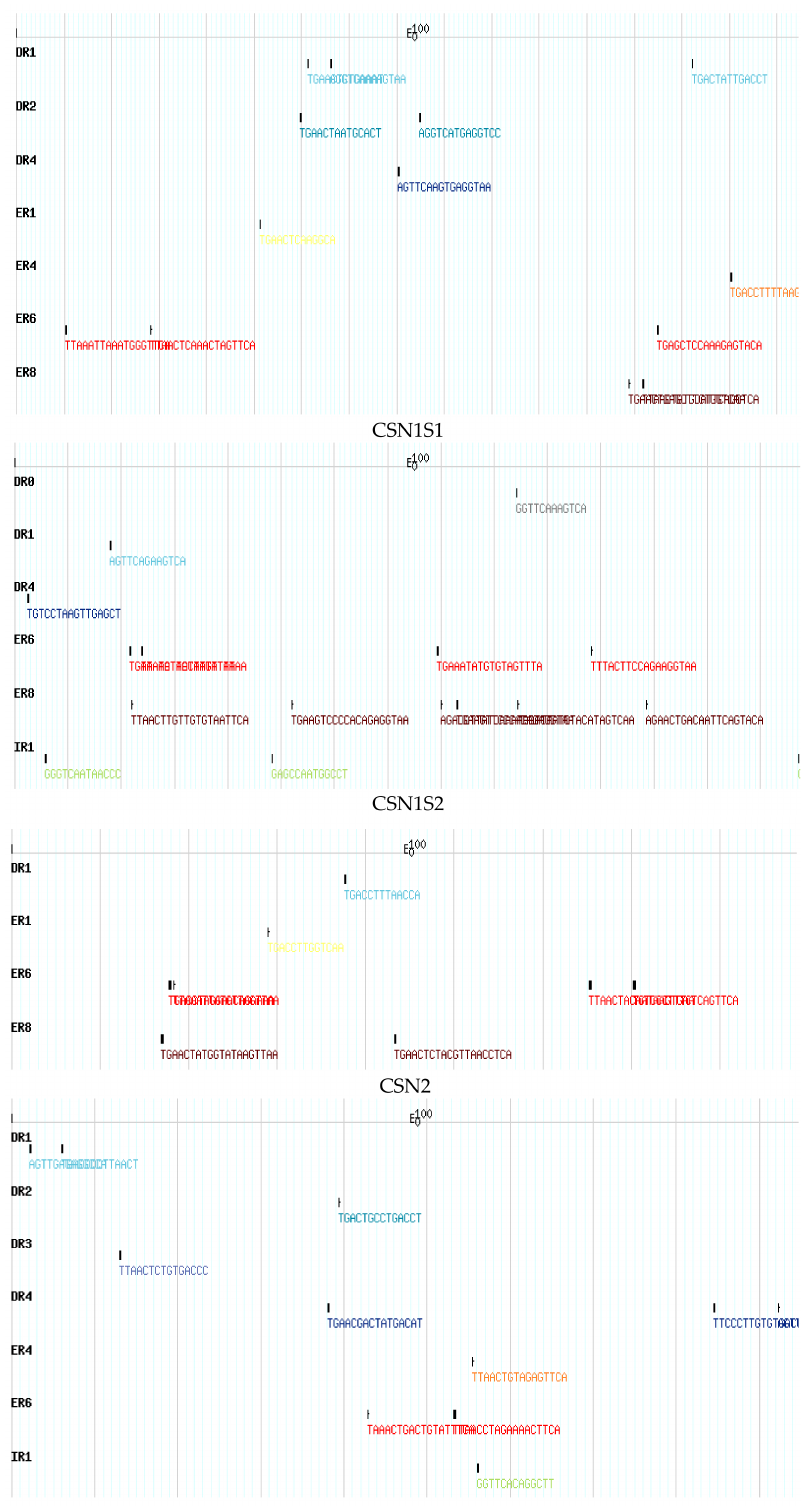
Figure 5. Nuclear hormone receptor site patterns in the casein gene family of Camelus ferus